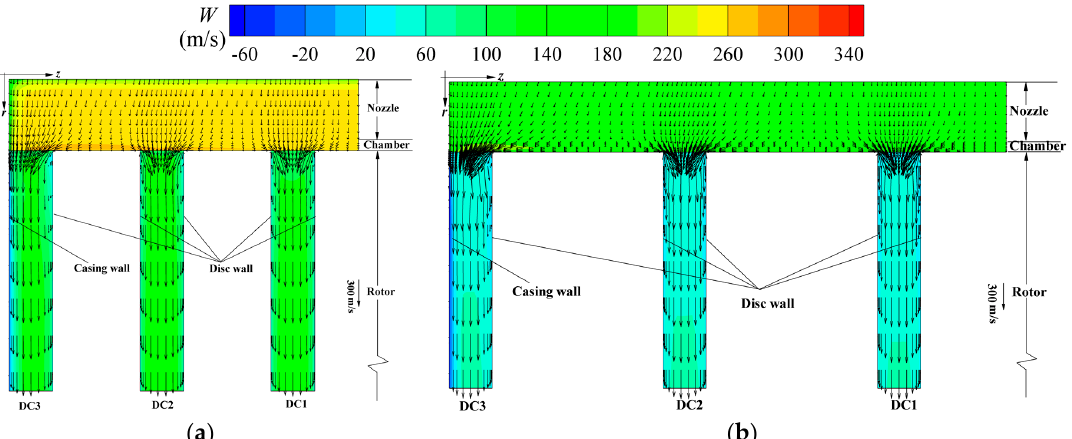
Figure 14. Contours of relative tangential velocity and vector distributions on radial cross-sections of 0° for the one-to-many Tesla turbine cases with different disc thickness: ( a ) Case 1-0.5; and ( b ) Case 2-0.5.